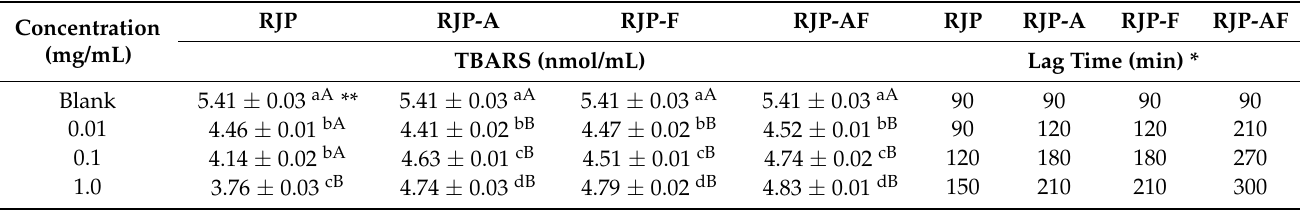
Table 5. Effects of protein and different hydrolysates obtained by alcalase and flavourzyme on the formation of a thiobarbituric acid reactive substance (TBARS) and conjugated dienes on low-density lipoprotein (LDL) oxidation induced by Cu 2+. Concentration (mg/mL)